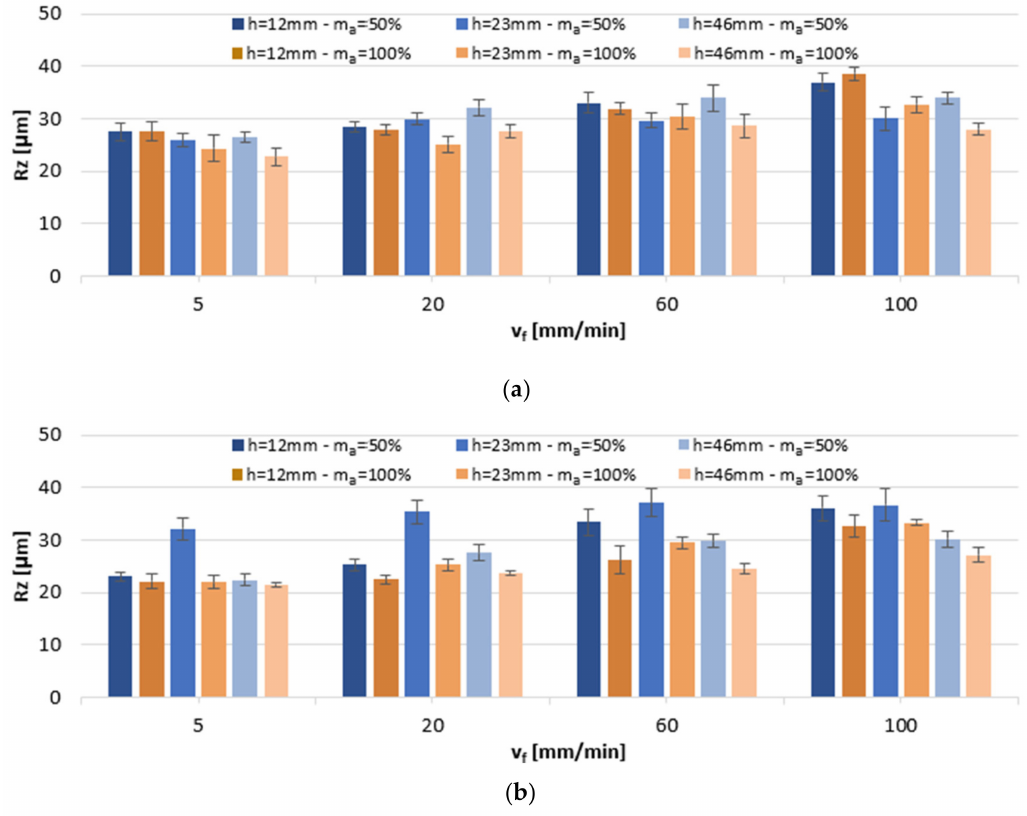
Figure 3. The impact of jet feed rate v f , sample height h, and abrasive flow rate m a on Rz of post-machined alloys: ( a ) AlSi10Mg and ( b )